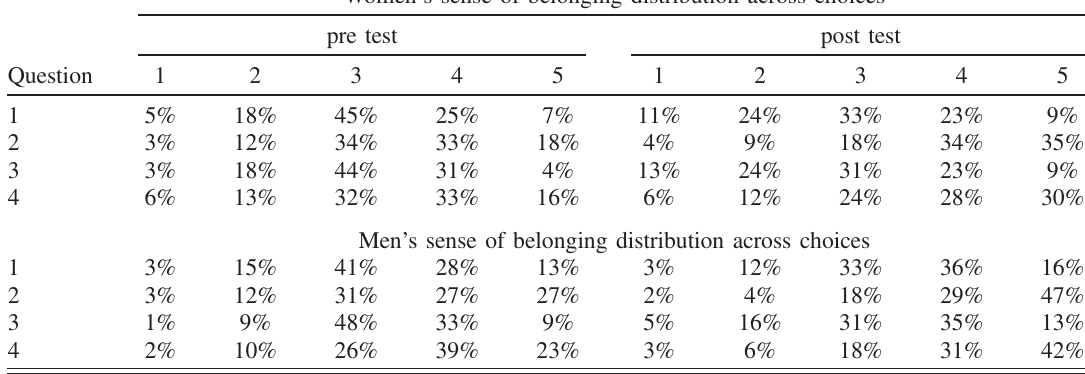
TABLE III. Percentages of 521 women and 293 in physics 1 who responded to each sense of belonging item by the options they selected with 1 being the low value (not at all true) and 5 being the high value (completely true). The rating scale for the sense of belonging items was: not at all true, a little true, somewhat true, mostly true, and completely